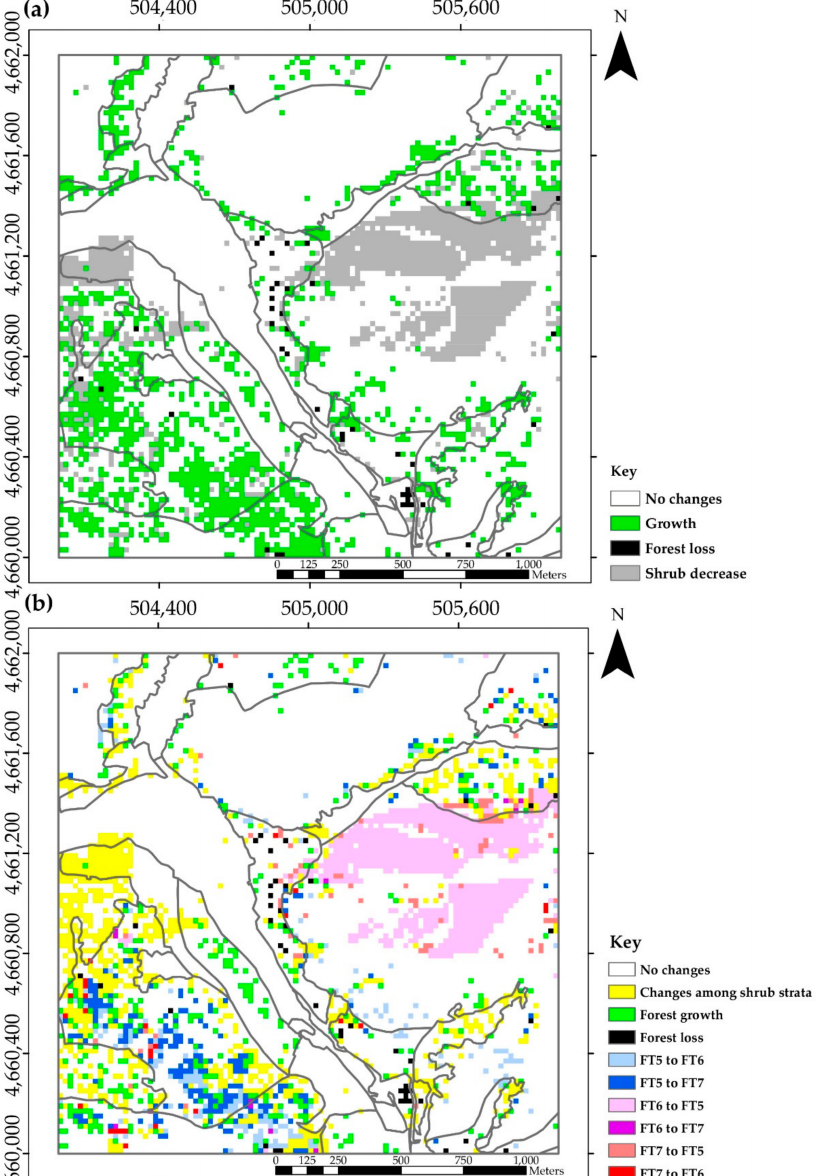
Figure 3. Fuel type changes between 2010 and 2016, with two alternative visualizations of the results obtained in FT changes. ( a ) Highlights general patterns increase or decrease of vegetation along vertical strata, whereas ( b ) provides more detail on the changes pertaining forested FTs. Borders of vegetation cover types (grey lines) are shown for reference. Legend in ( a ): Growth: FT changes involving a gain in higher vegetation strata; Forest loss: FT change involving a loss in tree strata (from FT5-7 to FT1-4). Shrub decrease: FT changes involving a loss in shrub strata (from FT7 to FT6-5, FT6 to FT5, or decreases within FT1-4). Legend in ( b ): Changes among shrub strata: change combinations within FT1-4; Forest growth: changes from FT1-4 to FT5-7; Forest loss: changes from FT5-7 to FT1-4. Changes among forest FTs (FT5-7) are further detailed, with colors denoting the FT in 2016 and pale/dark shades the change in